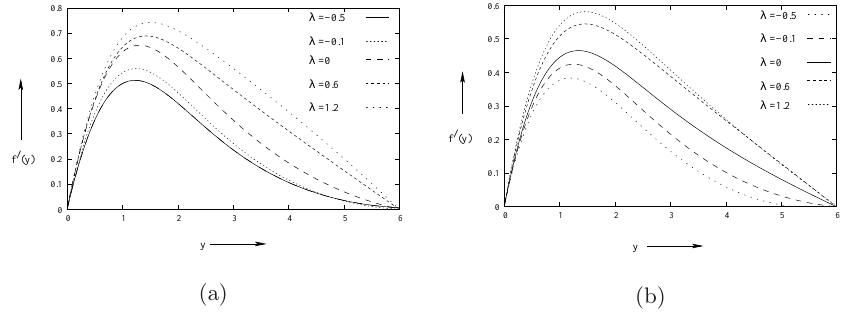
Figure 4. Variation of velocity profiles with y for several values of λ when a) k 1 = 0 and Pr = 0 . 1 , b) k 1 = 0 . 5 and Pr = 0 . 1